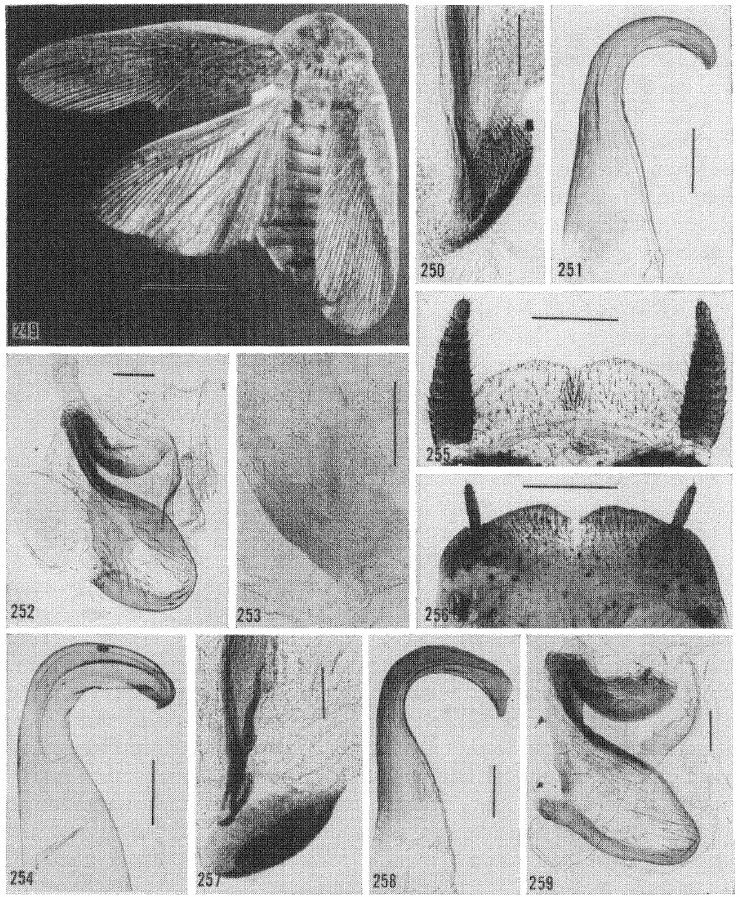
6 mm; Fig. 250 0.1 mm; Figs. 251-254, 257- 259 0.2 mm; Figs. 255-256